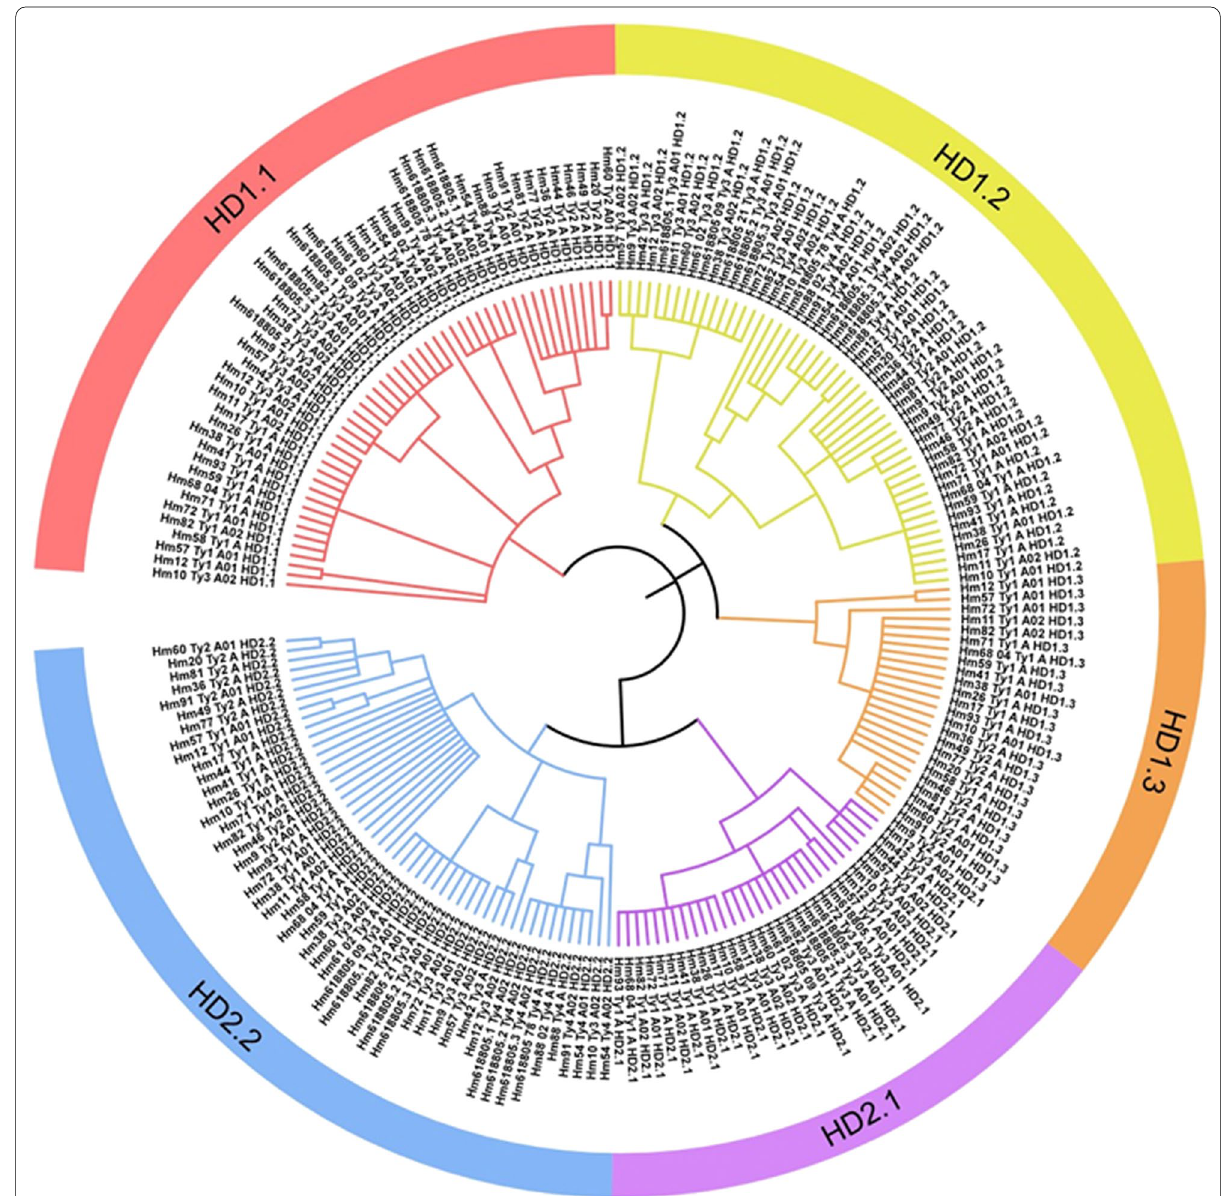
Fig. 2 The phylogenetic trees based on 223 HD genes from 54 H. marmoreus strains. Different color blocks represent three HD1s and two